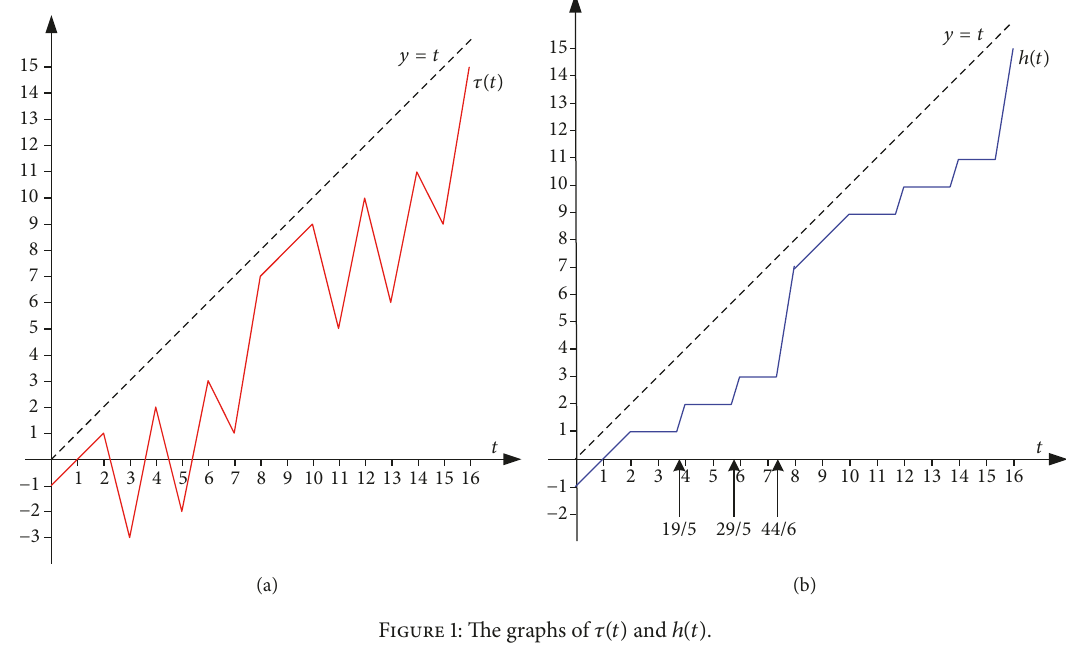
Figure 1: The graphs of 𝜏(𝑡) and ℎ(𝑡)